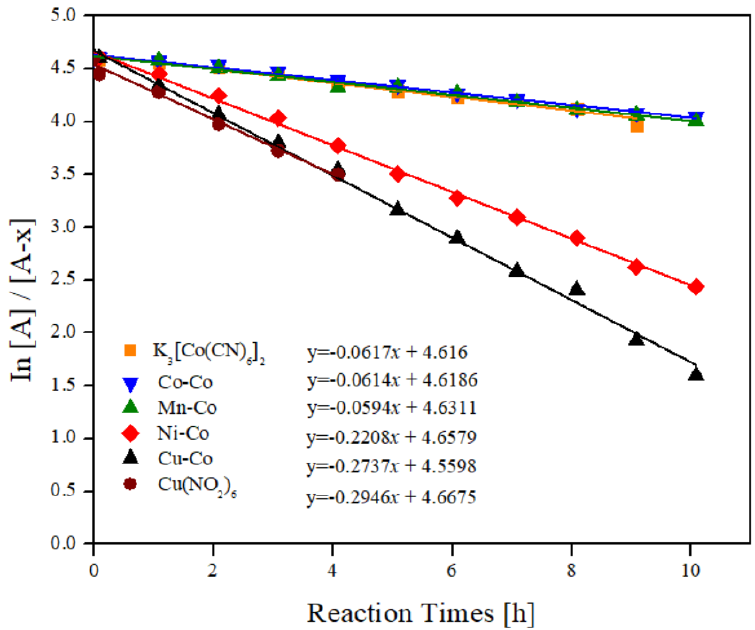
Figure 9. Graphs of ln [A] / [A–x] vs. reaction time with Mn–Co, Co–Co, Ni–Co, and Cu–Co catalysts at 75 °C.